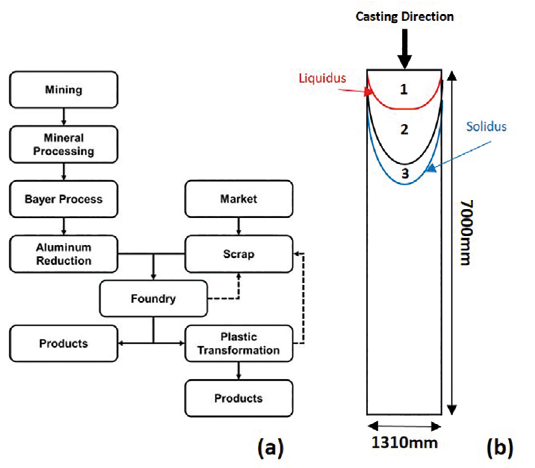
Figure 2. a) Schematic representation of the manufacturing route to obtain the samples of AA5052 aluminum alloy, b) Schematic representation of the liquidus (L) and solidus (S) isothermal transition zone in a casting crucible. The isothermal coherency is defined as 30%. (1) The liquid reservoir depth; (2) transition zone; (3) mushy